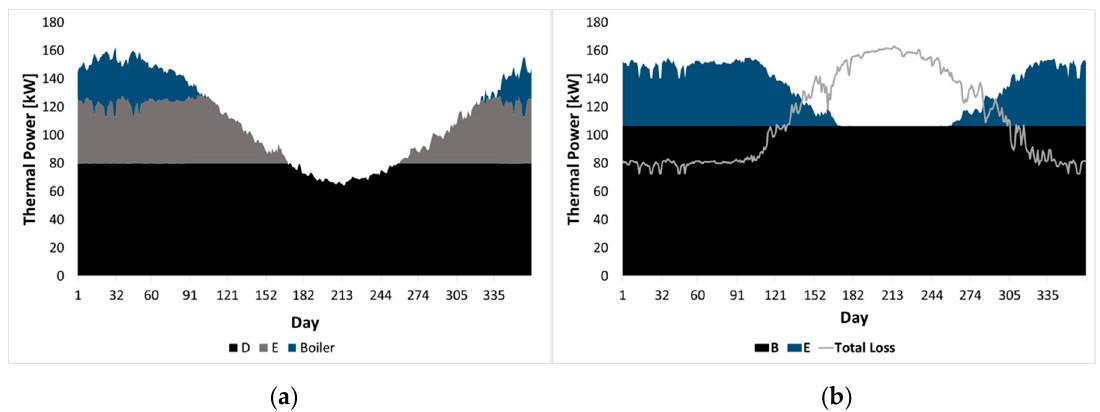
Figure 9. The thermal power required to heat sludge divided by components ( a ) and the mGT exhaust gas thermal power contributions ( b ). Capital letters B, D, and E refer to Figure 7.